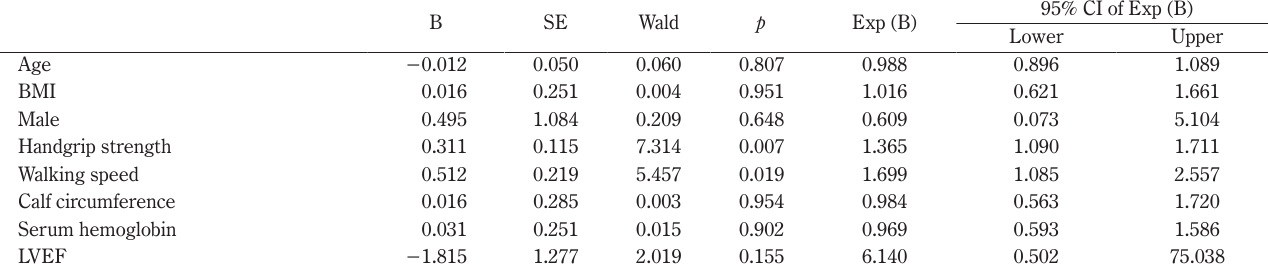
Table 2 Multiple regression analysis for predictors of determinable